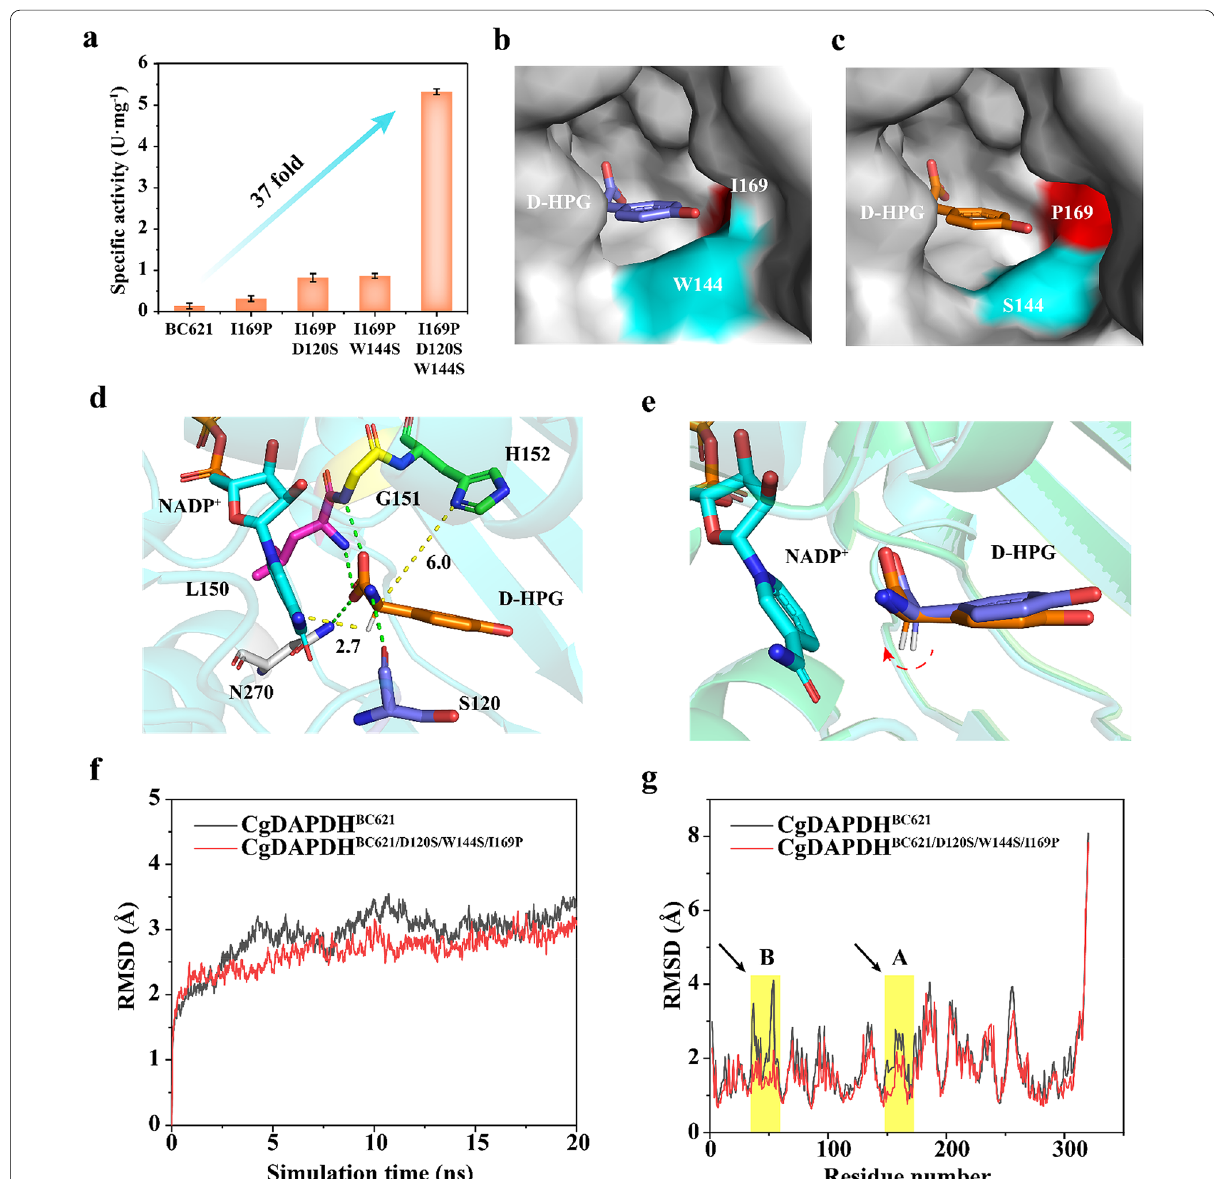
Fig. 5 Improvement of the catalytic activity of Cg DAPDH BC621 toward HPGA by “conformational rotation” strategy. a Directed evolution of the parent Cg DAPDH BC621 for reductive amination of HPGA. b The binding pocket surface of Cg DAPDH BC621 . D-HPG is shown in purple. c The binding pocket surface of Cg DAPDH BC621/D120S/W144S/I169P . D-HPG is shown in orange. d Docking of the D-HPG into the active site of Cg DAPDH BC621/D120S/ W144S/I169P . D-HPG is shown in orange, NADP + cofactor is shown in cyan, residue S120 is shown in purple, L150 is shown in magenta, G151 is shown in yellow, and H152 is shown in green. The hydrogen bond between D-HPG and residues S120, L150, G151, and N270 are shown in green dash lines, respectively. The yellow dash lines denote d (C6HDAP and d (C6DAP , respectively. e Superposition of the D-HPG conformation − C4NNADP) − ND1His152) in parent Cg DAPDH BC621 and variant Cg DAPDH BC621/D120S/W144S/I169P . f – g RMSD values calculated from MD simulations of Cg DAPDH BC621 and Cg DAPDH BC621/D120S/W144S/I169P . The highlight represented the changes of the region with noticeable movements for Cg DAPDH